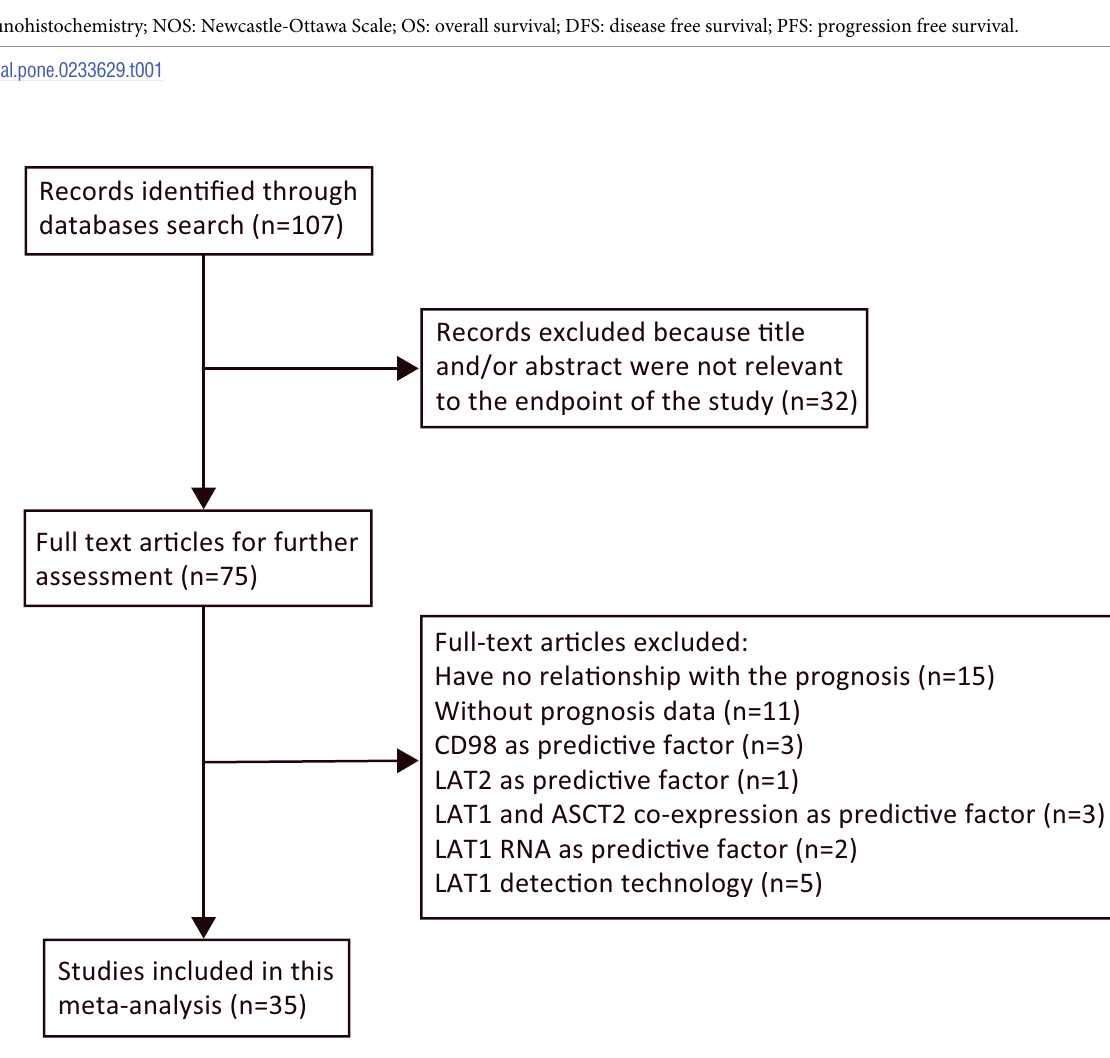
Fig 1. The flow chart of the selection process in our